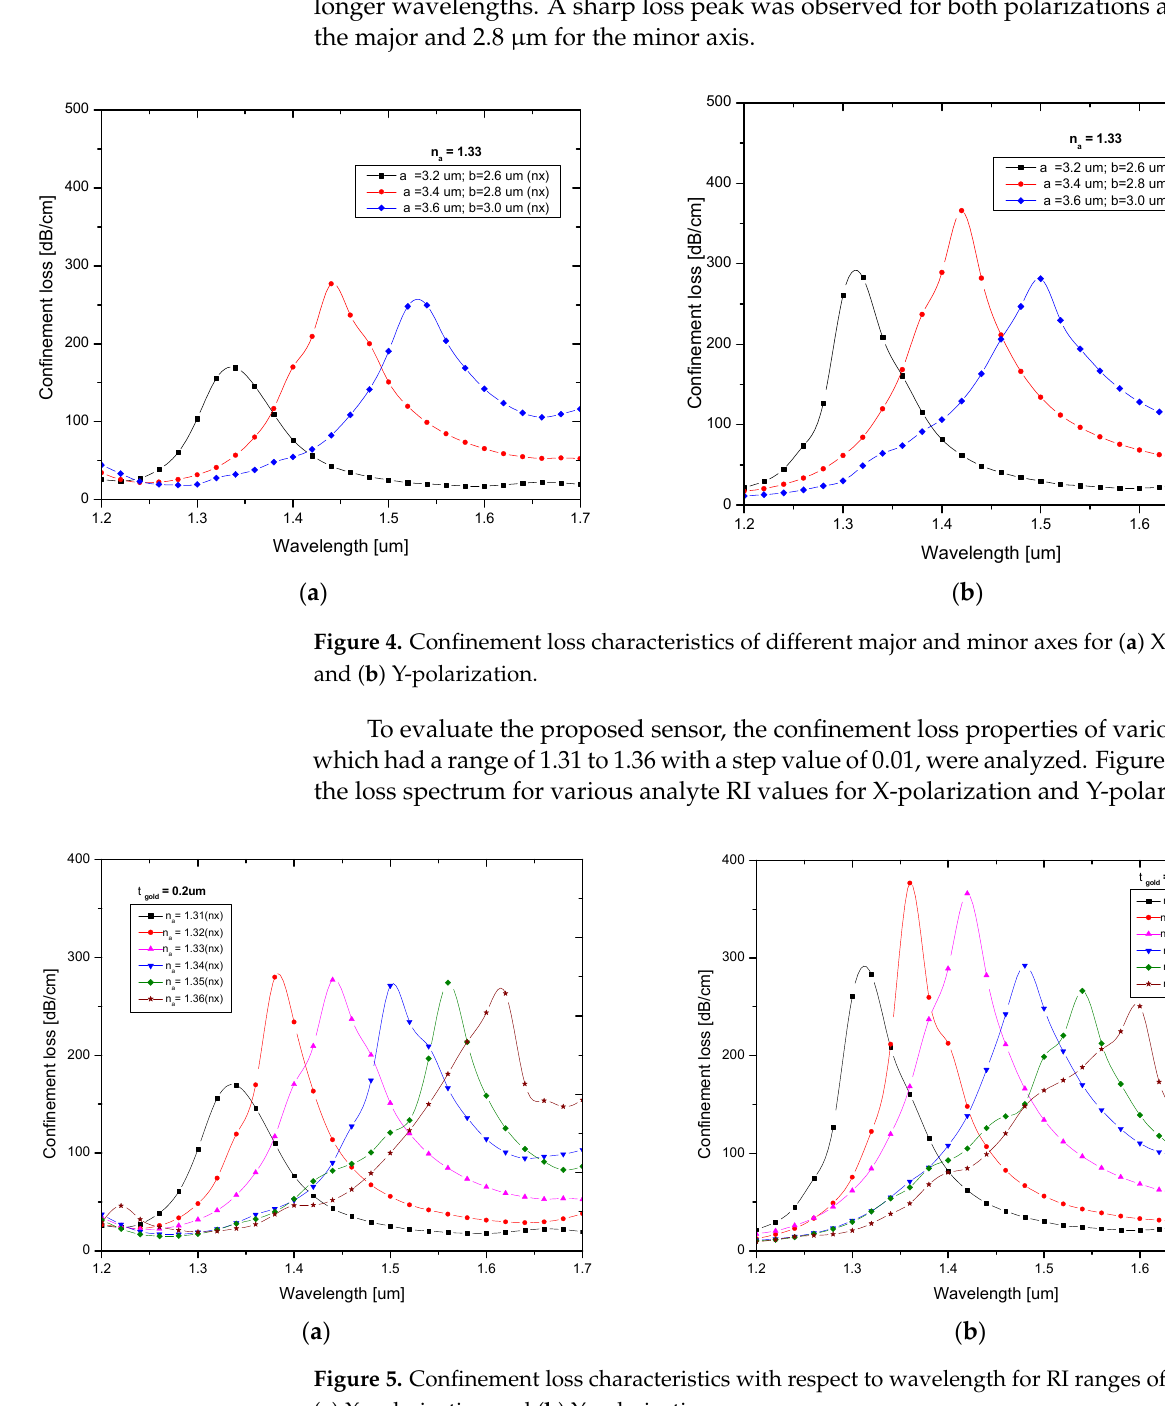
Figure 3. Confinement loss characteristics for different values of d1 for ( a ) X-polarization and ( b ) Y- polarization.